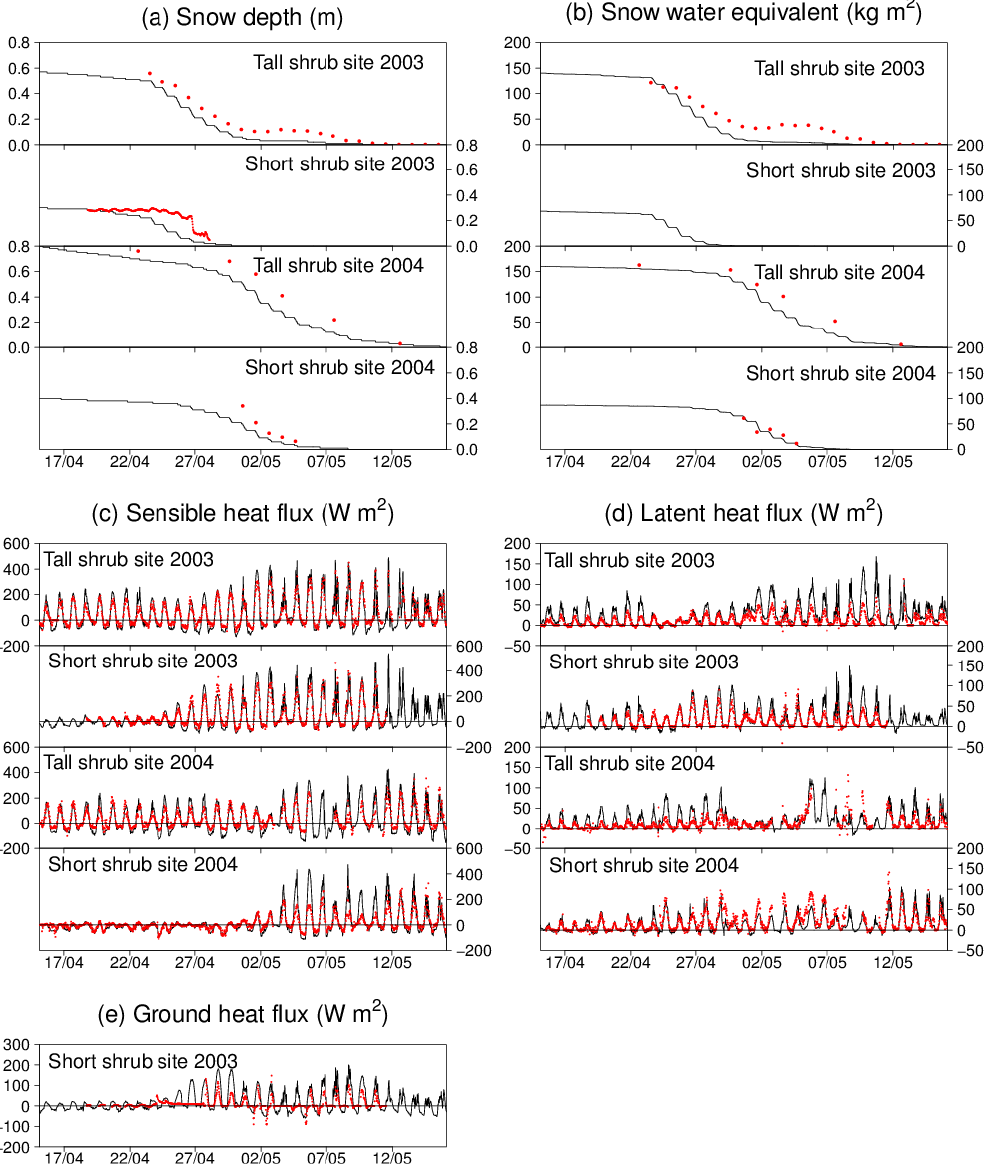
Figure 3. Measured (dots) and modelled (lines) (a) snow depth, (b) snow water equivalent, (c) sensible heat flux, (d) latent heat flux and (e) ground heat flux during snowmelt in 2003 and 2004. Snow depth and water equivalent measurements were manual (automatic snow depth at the short shrub site in 2003) and fluxes were measured using eddy correlation